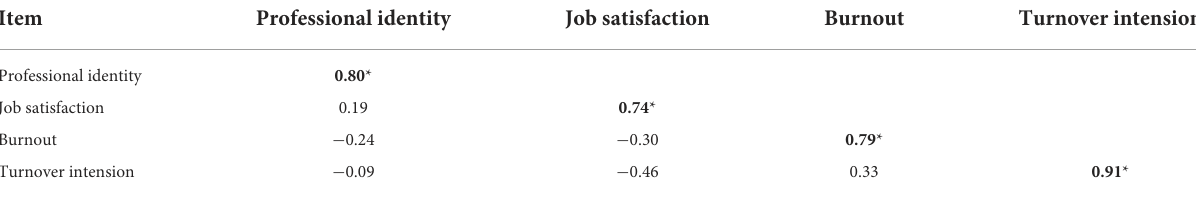
TABLE 5 Correlation and discriminant validity between potential